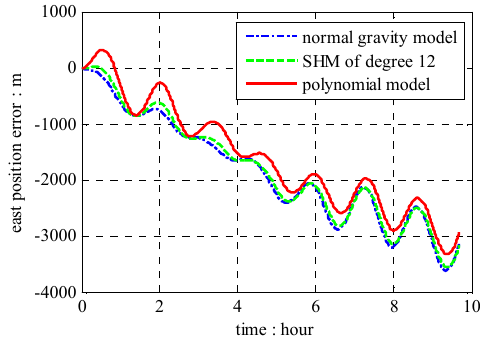
Figure 14. Position errors of east components.